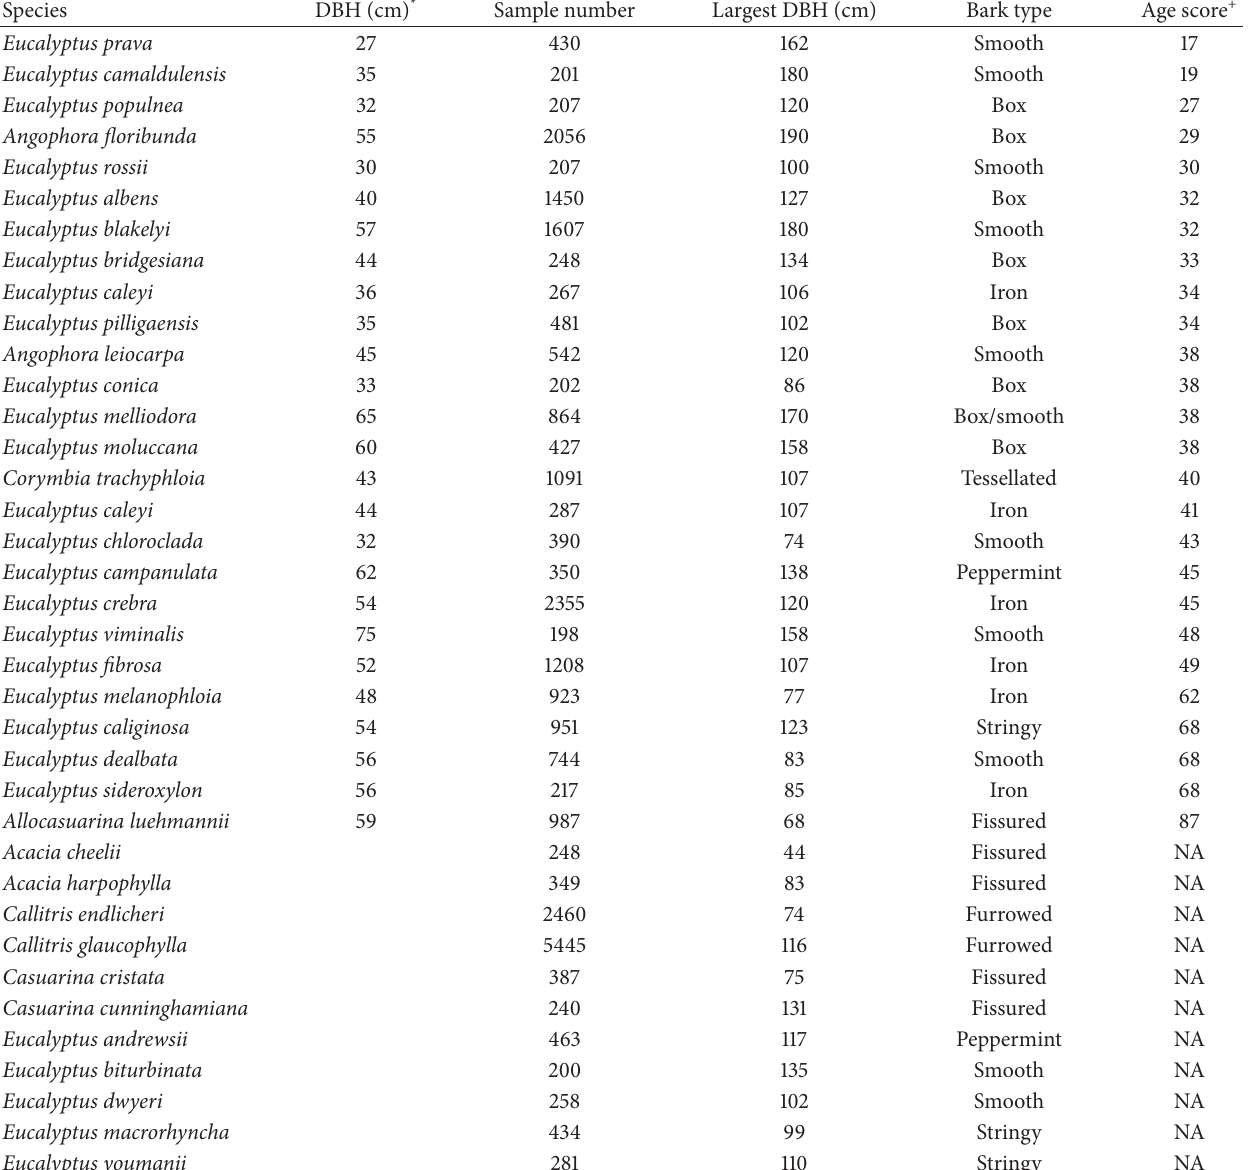
Table 2: Selected features of collected data for species with over 200